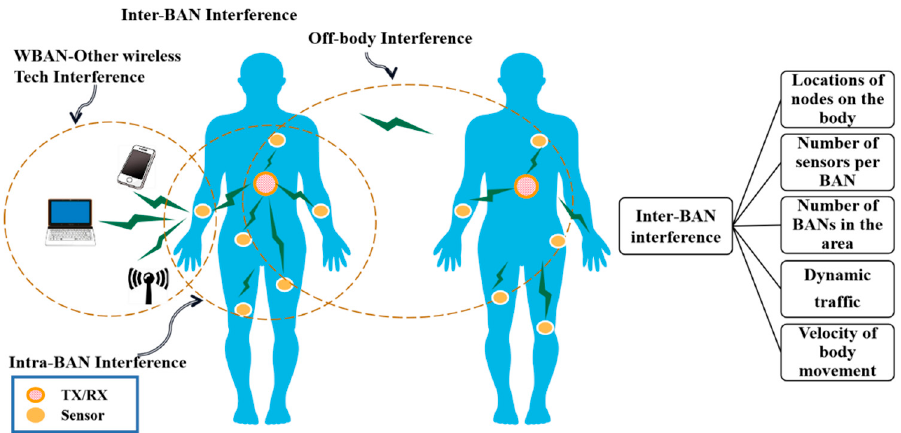
Figure 4. BAN interference.